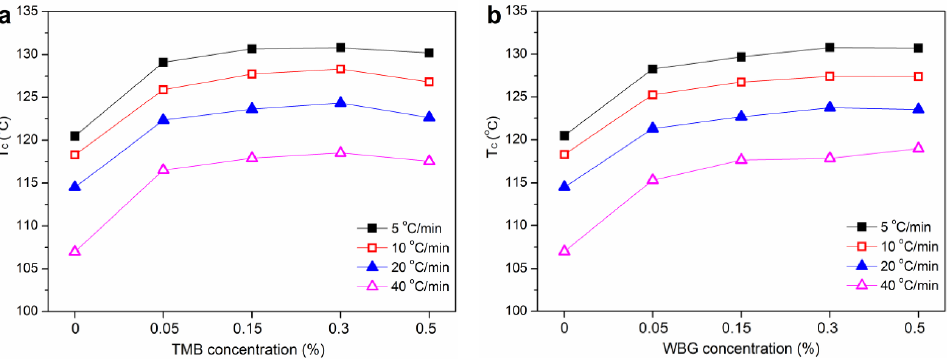
Figure 6. Variation of crystallization peak temperature ( T c ) with nucleating agent concentration and cooling rate for ( a ) WF/PP-TMB and ( b ) WF/PP-WBG.